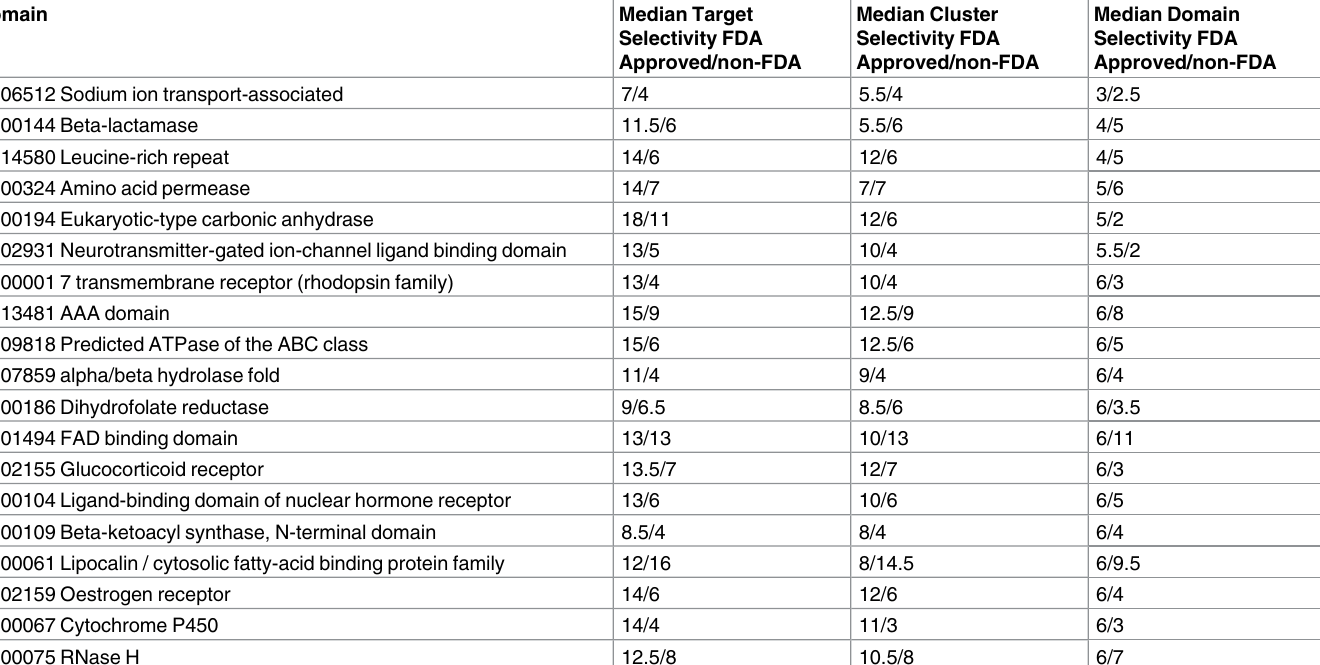
Table 5. Top 19 pfam domains with most selective active drugs. Only domainspresent in the H. sapiens proteomeare shown, and are sorted and selectedby increasing domainselectivity amongFDA approved drugs. We also excludeddomainswith under 100 amino acid residues in the homology model, to avoid small repeats and domains unlikelyto be drug targets. Additionally,we report for multi-domain clusters only the most frequent and functionally descriptivemembers as outlinedin the Methods section (see “De-duplication of SingleDomainClusters”), and also removeddomainsof unknownfunction (DUFs). To the left of the slash in each column is the mediantarget selectivity of FDA approved compoundsactive againstthis domain,and to the right is the medianselectivity of non-FDA compounds. Selectivity is quantifiedby three methods of increasingly groupedprotein targets as describedin the text.